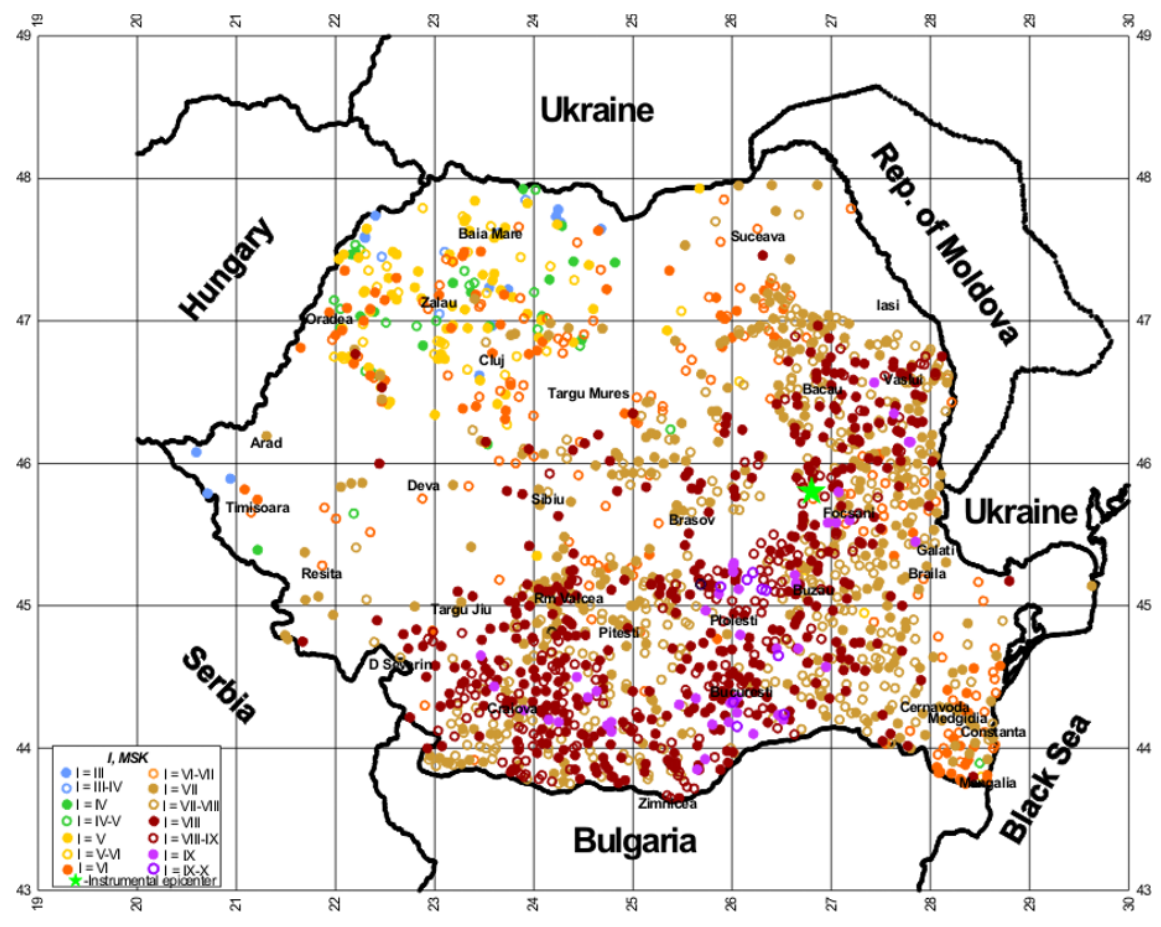
Figure 7. Re-evaluated macroseismic map of the March 4, 1977, subcrustal